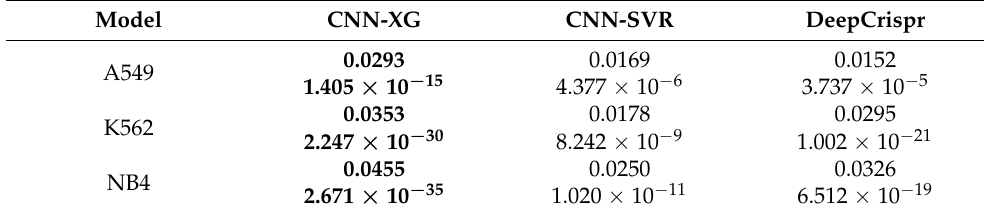
Table 7. Pearson correlations and p-values on generalization test